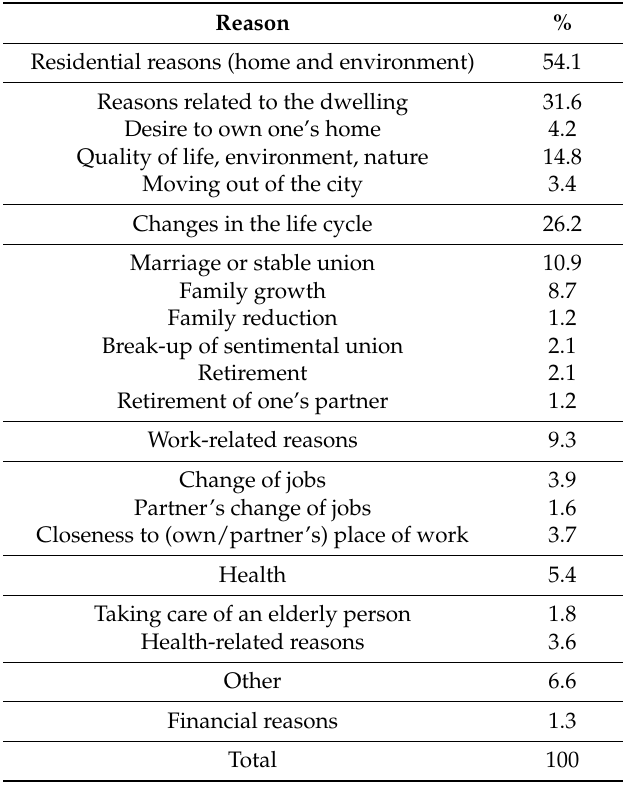
Table 4. Reasons for moving to a surburban residential